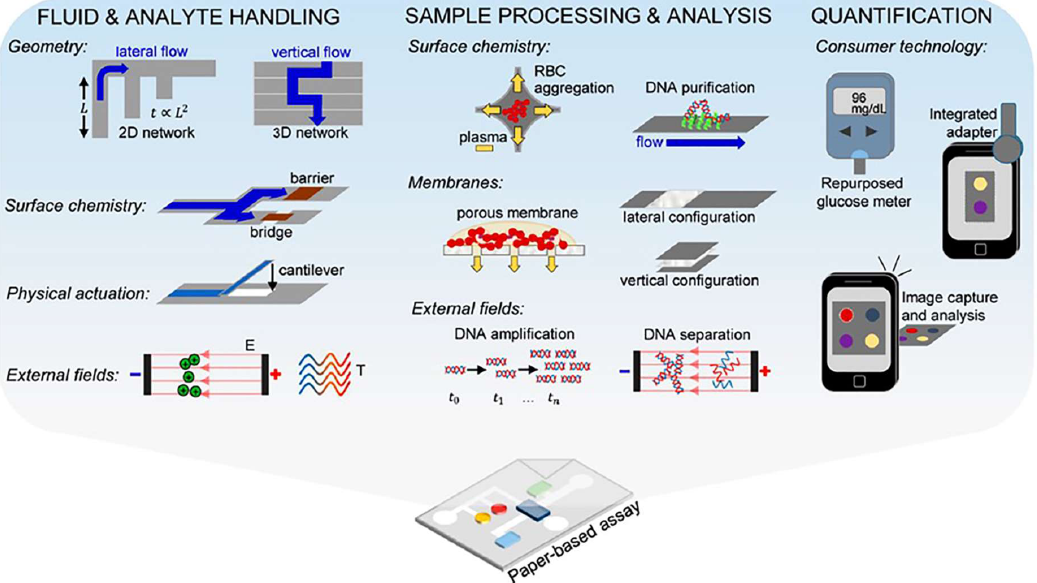
Figure 1. Overview of the analytical capabilities that are employed in paper-based sensors. Paper- based assays with strategies for fluid and analyte handling, sample processing and analysis, and quantification. Reproduced with permission from